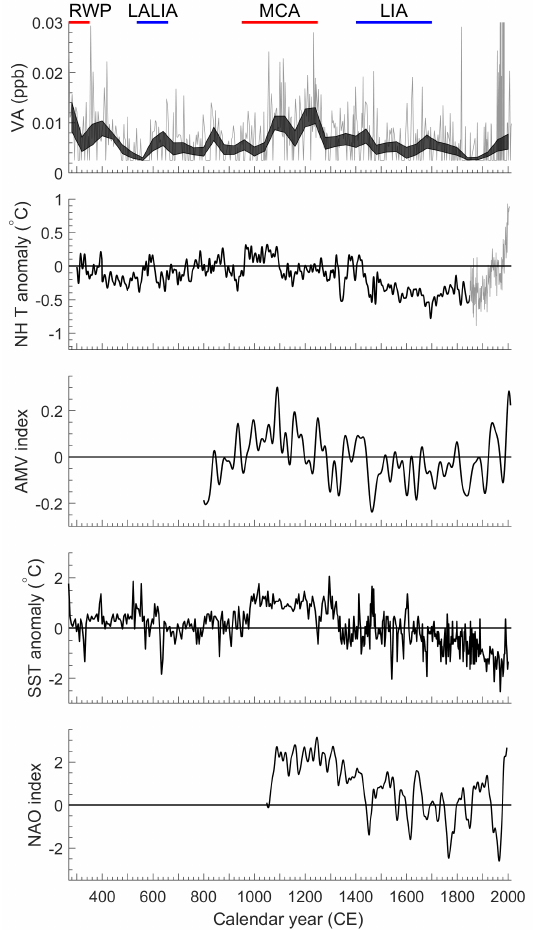
Figure 9. Comparison between Tunu VA and climate records. From top: Tunu VA, the gray-filled lines are ± 1 standards error of the 40-year bin averages of the data; Northern Hemisphere land tem- perature anomaly composite before 1850 (EIV method; black line) and after 1850 (CRU instrumental record; gray line; Mann et al., 2008a, b; Wang et al., 2017a, b; Sicre et al., 2011a, b; Trouet et al., 2009a, b); 30-year low-pass-filtered Atlantic multidecadal variabil- ity (AMV) (Wang et al., 2017a, b), b; North Atlantic alkenone sea surface temperature (SST) anomaly based on MD99-2275 sediment (Sicre et al., 2011a, b); and North Atlantic Oscillation (NAO) index reconstruction (Trouet et al., 2009a,